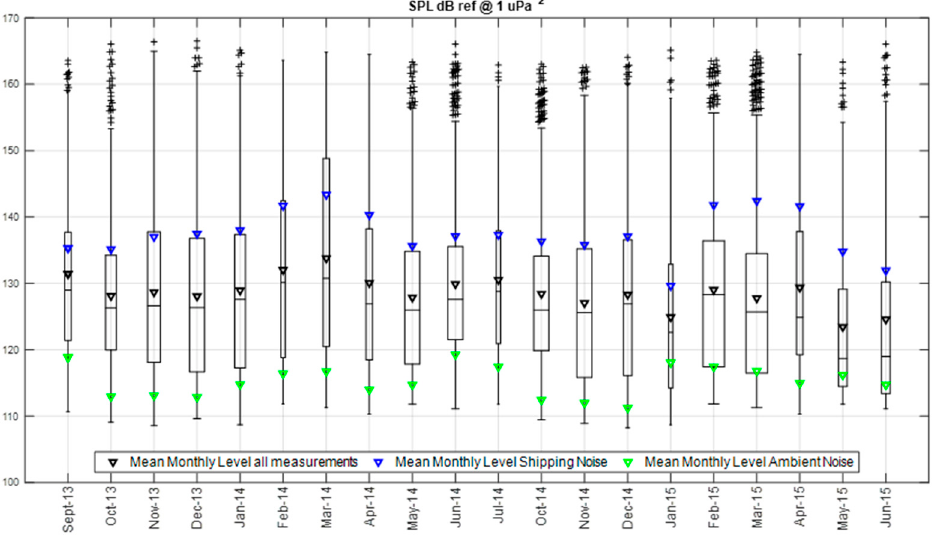
Figure 11. Mean and median monthly evolution of the SPL level of all measurements. The mean monthly values of shipping, other anthropogenic and natural noise measurements are represented as blue, black and green triangles, respectively.